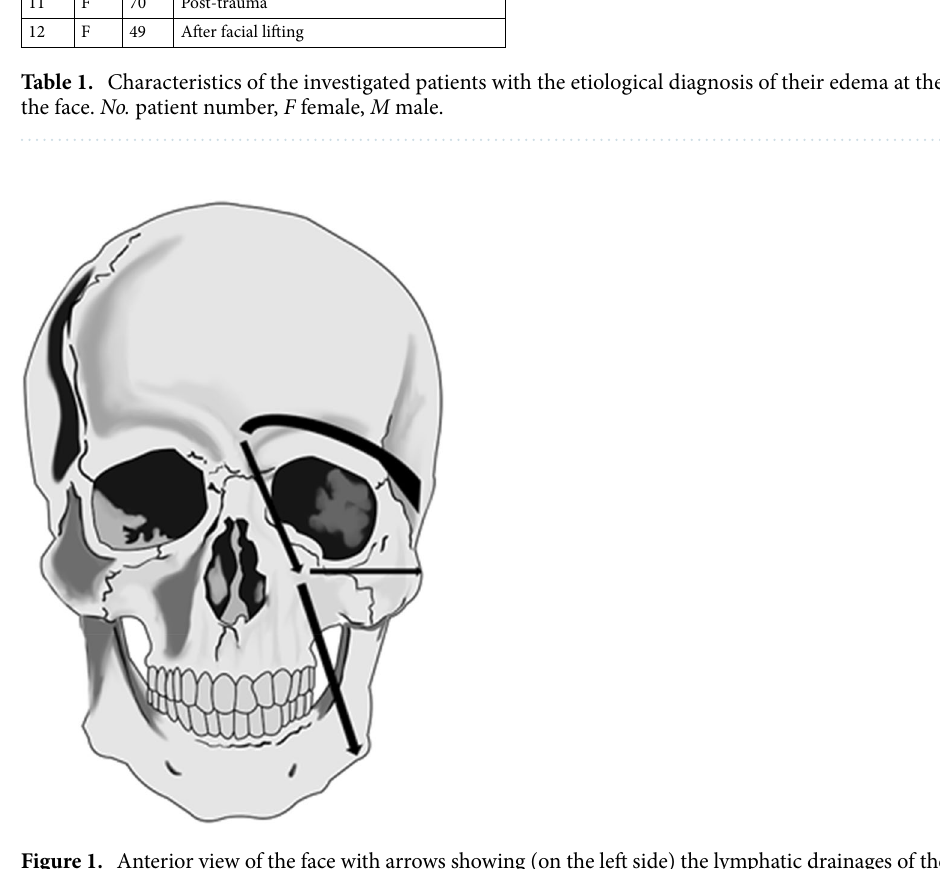
Figure 1. Anterior view of the face with arrows showing (on the left side) the lymphatic drainages of the injected site: supra-ocular to the pre-auricular LN and para-nasal to (1) the sub-mandibular LN, (2) the pre- auricular LN and (3) the parotid